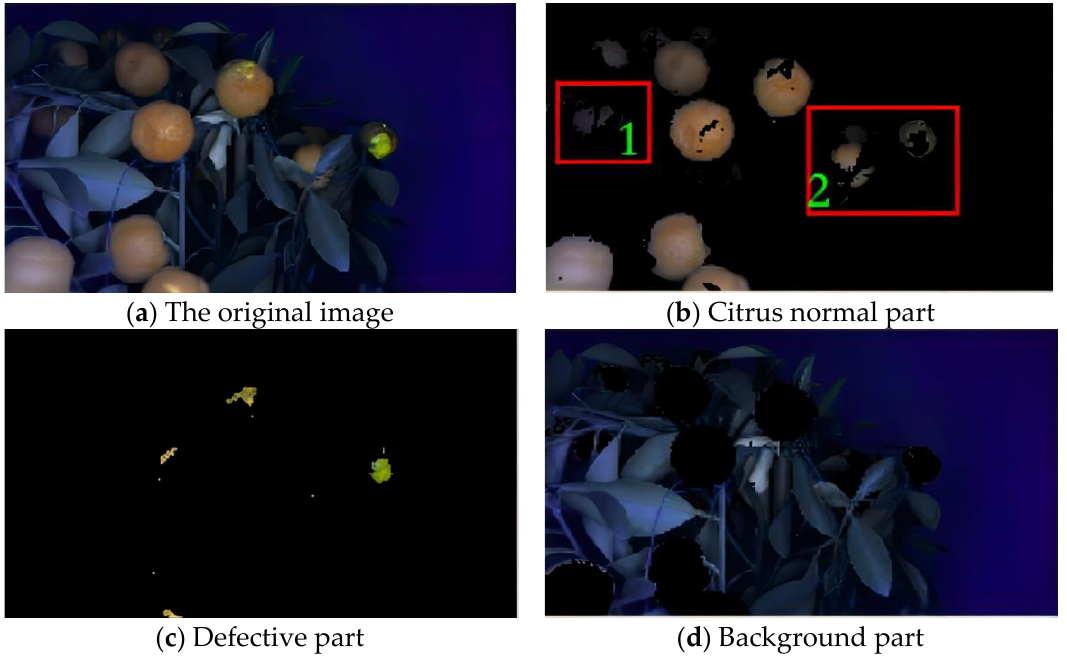
Figure 11. SVM model classification results of citrus UV image. Box 1 and box 2 show the detection result when there is a leaf occlusion.